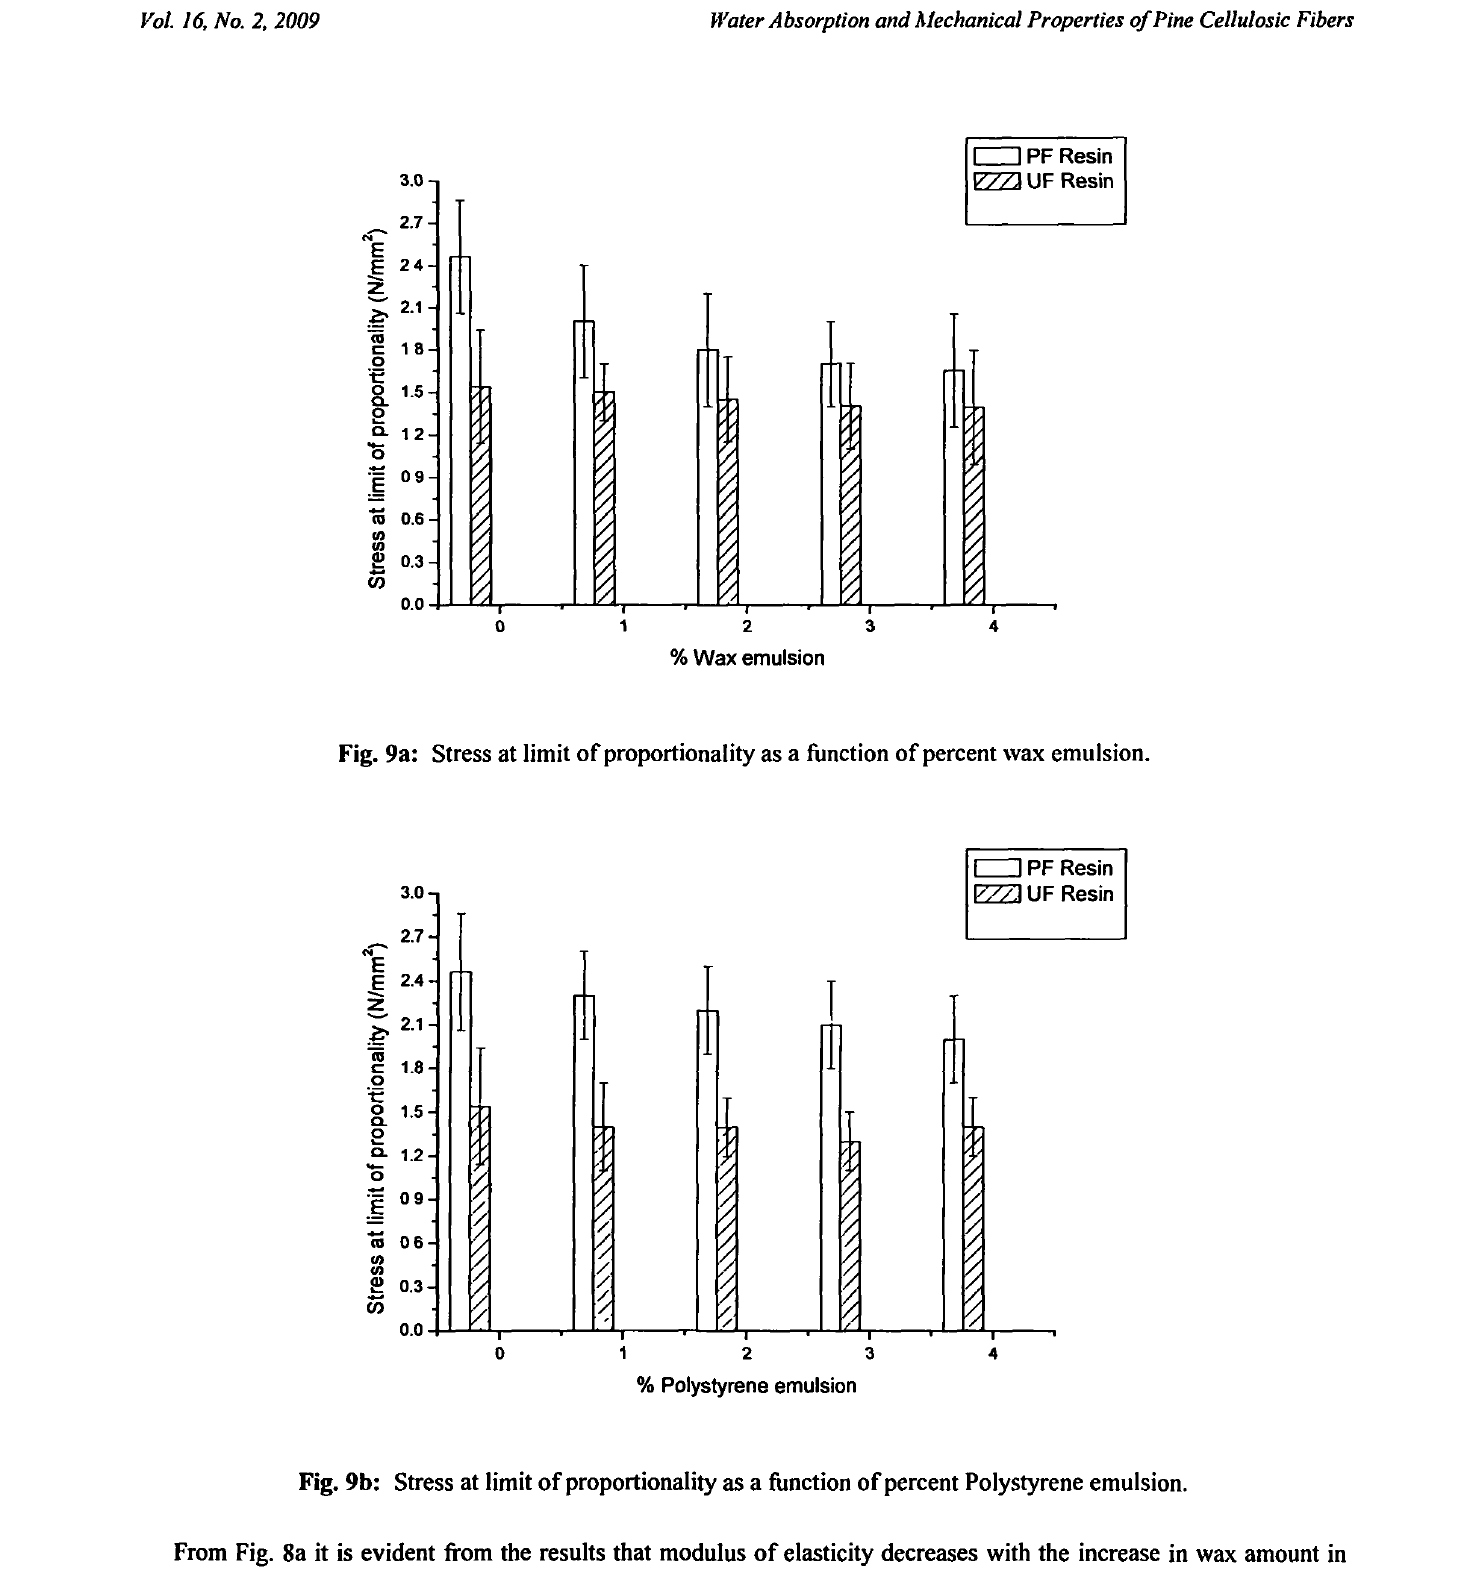
Fig. 9b: Stress at limit of proportionality as a function of percent Polystyrene